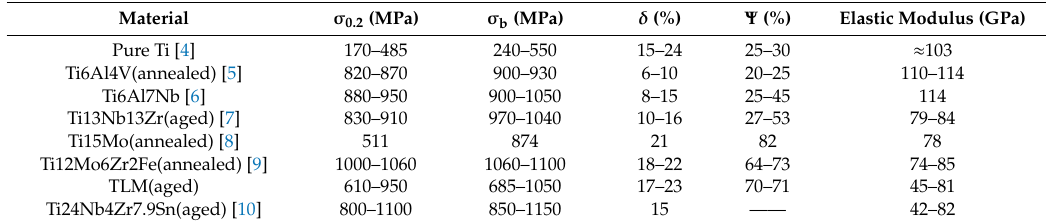
Table 1. Mechanical properties of some titanium alloys for biomedical